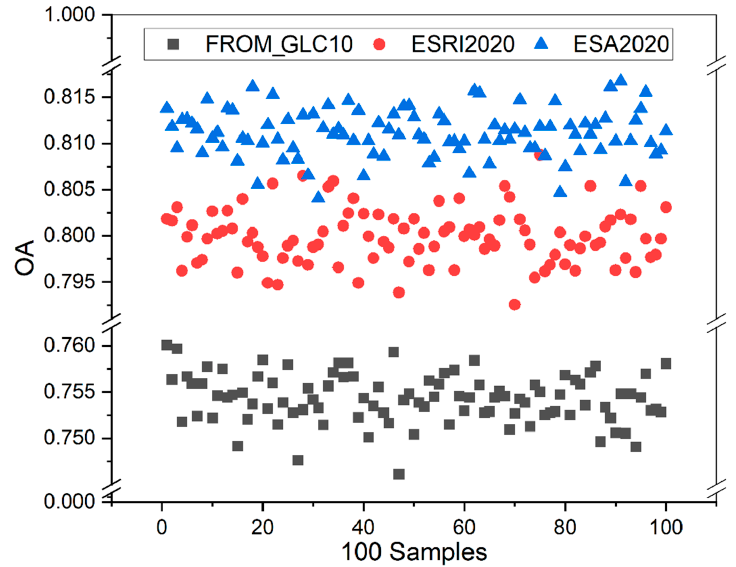
Figure 8. Overall accuracy values calculated with 100 samples.